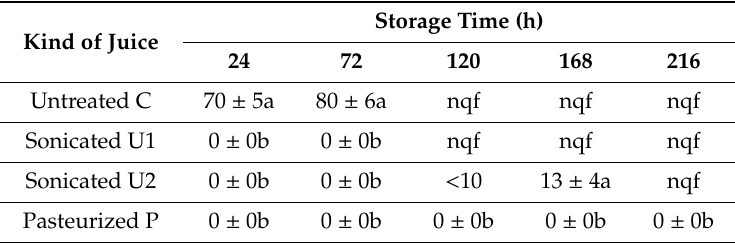
Table 3. Total number of mesophilic microorganisms (cfu / mL) in apple juice from piston press after ultrasound treatment stored at 4 ◦ C. Di ff erent letters in the same column indicate values significantly di ff erent at P < 0.05.